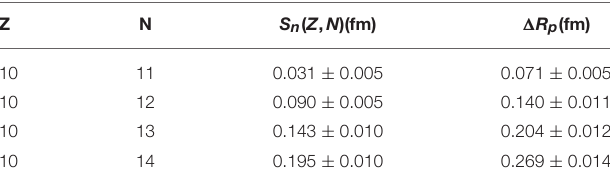
TABLE 6 | Relation between the neutron skin of nucleus ( Z , N ), S n ( Z , N ), and 1 R p for the isotope chain Z =